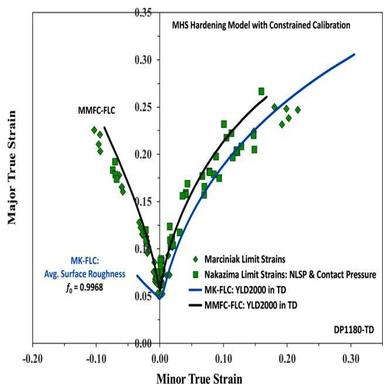
Comparison of the Marciniak and process-corrected Nakazima FLC data with MMFC-predicted FLCs in the transverse direction using von Mises and Yld2000 with the constrained MHS hardening model.